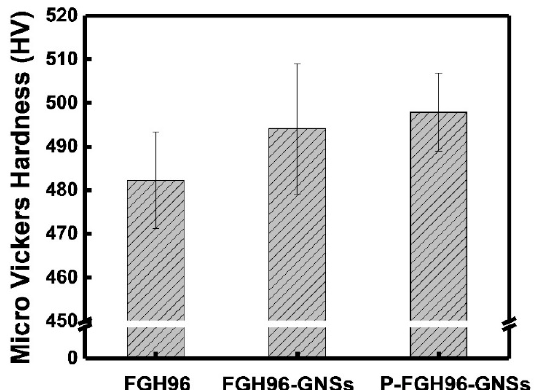
Figure 10. The microhardness of the matrix FGH96, 0.1 wt.% GNSs/FGH96, and PVA modified 0.1 wt.% GNSs/FGH96 composites, respectively.